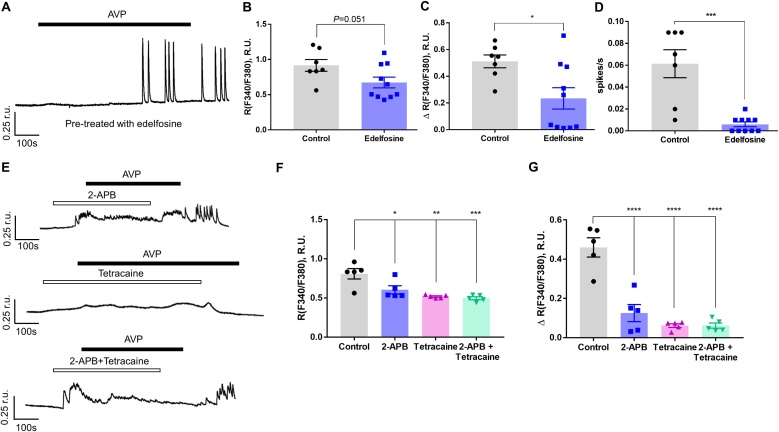
AVP-induced Ca2+ oscillations are reduced by inhibition of PLC and ER Ca2+ release channels. (A) Representative example trace showing Ca2+ oscillations (indicated as F340/F380 ratio units; r.u.) evoked by AVP (100 pM) in A7r5 cells pretreated with the phospholipase C (PLC) inhibitor, edelfosine (10 μM). (B-D) Bar graphs summarising the effects of edelfosine on the peak Ca2+ level (B), Ca2+ response amplitude (ΔR; C) and Ca2+ spike frequency (spikes/s) (D) induced by AVP. (E) Example traces of AVP-induced Ca2+ transients recorded in the presence of 2-APB (IP3Rs inhibitor; 100 μM) or tetracaine (RyRs inhibitor; 100 μM), as indicated. (F,G) Bar graphs summarising the effects of the effects of 2-APB or tetracaine on the peak Ca2+ level (F) and Ca2+ response amplitude (ΔR; G) induced by AVP. In panels B-D and F-G data are presented as mean ± S.E.M.; *P < 0.05, **P < 0.01, ***P < 0.001, ****P < 0.0001 (panel B-D, Control, n = 7, edelfosine, n = 10; panel F-G, n = 5).